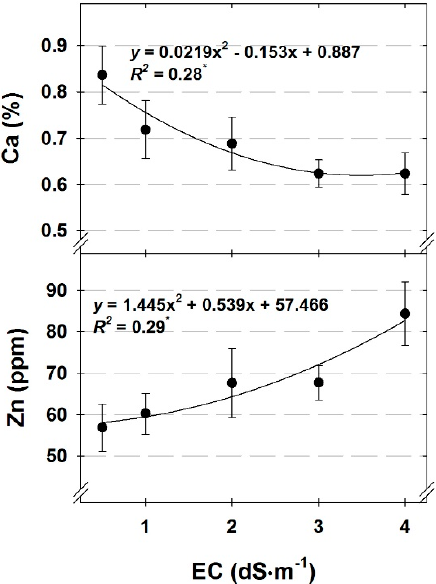
Figure 5. Tissue Ca and Zn of parsley ( Petroselinum crispum ‘Giant of Italy’) 4 weeks after transplanting into nutrient-film technique hydroponic systems in a greenhouse under a low (~7 mol · m − 2 · d − 1 ) or high (~18 mol · m − 2 · d − 1 ) daily light integral (DLI) with a range of nutrient solution electrical conductivity (EC; 0.5 to 4.0 dS · m − 1 ) treatments. Data were pooled across daily light integrals within EC. Each symbol represents the mean of six replications with ten plants per replicate, and error bars represent the standard errors s of the mean of the six replicates. * indicates significant at p ≤ 0.05.